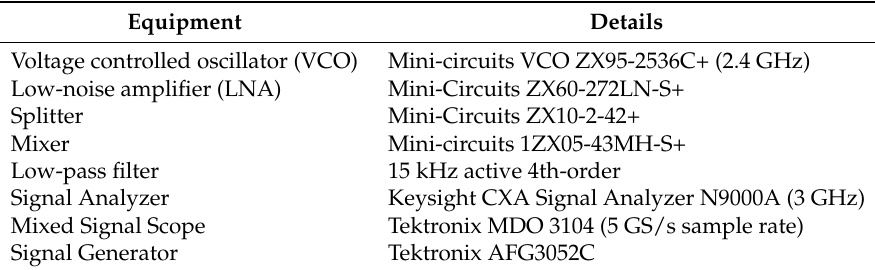
Table 3. Lab equipments and RF components used in